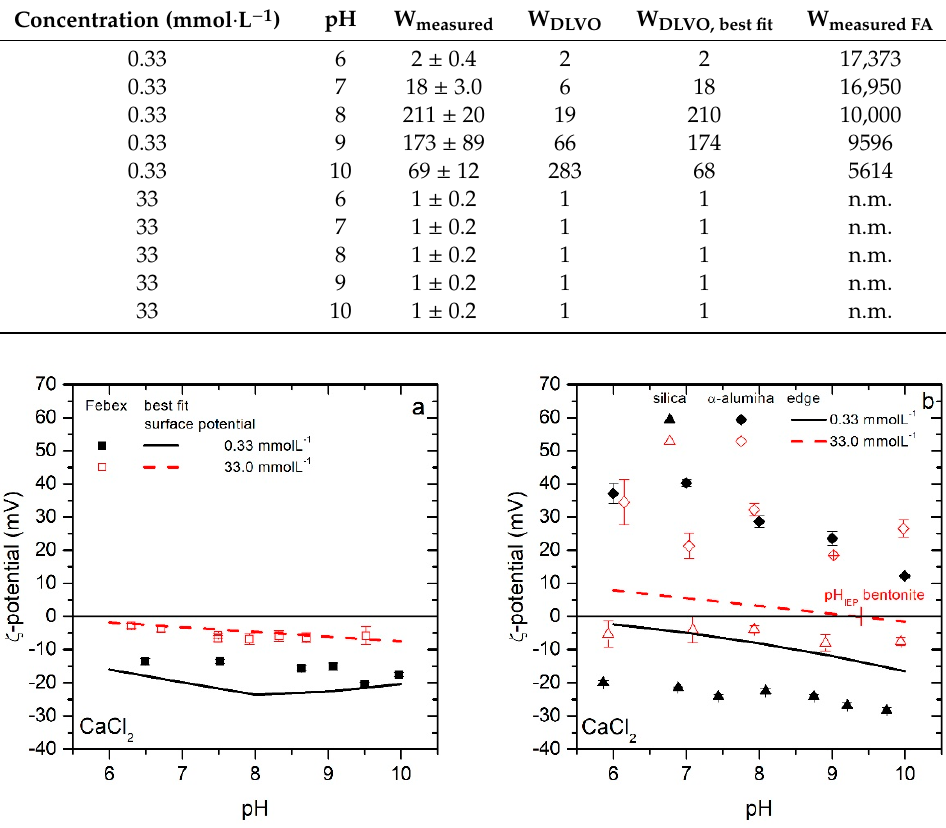
Figure 5. ( a ) FEBEX bentonite colloid ζ -potential in CaCl 2 background electrolyte solution. Data points represent the measured ζ -potentials at 0.33 mmol · L − 1 (filled squares) and 33 mmol · L − 1 (open squares) as a function of pH. The solid lines represent the best fits for the surface potentials to reproduce the measured stability ratios, as given in Table 1. The value of the surface electrokinetic potential is given in Table S6. ( b ) Silica (triangles) and α -alumina (diamonds) ζ -potential in CaCl 2 background electrolyte solution. Data points represent the measured ζ -potentials at 0.33 mmol · L − 1 (filled) and 33 mmol · L − 1 (open) as a function of pH. The lines indicate the estimated edge electrokinetic potential for the two electrolyte concentrations using Equation (4).